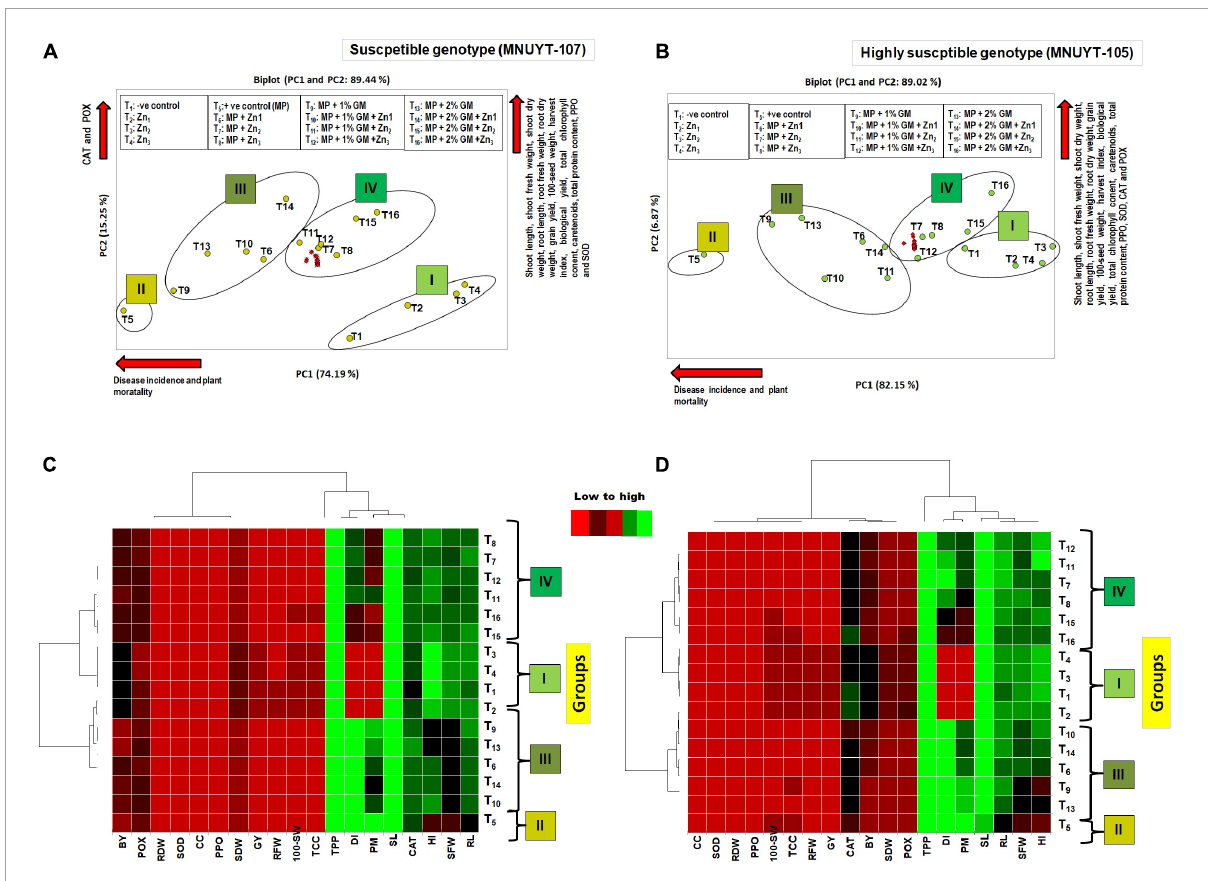
FIGURE4 (A–D) Principal component analysis and heatmap of disease pressure, biophysical, biochemical traits of mungbean genotypes due to the effect of Macrophomina phaseolina (MP), zinc (Zn), and green manure (GM) in pots bioassays. DI, disease incidence; PM, plant mortality; SL, shoot length; SFW, shoot fresh weight; SDW, shoot dry weight; RL, root length; RFW, root fresh weight; RDW, root dry weight; SW, 100 seed-weight; GY, grain yield; BY, biological yield; HI, harvest index; TCC, total chlorophyll content; CC, carotenoids; TPC, total protein content; SOD, superoxide dismutase; CAT, catalase; POX, peroxidase; PPO, polyphenol oxidase. In PCA diagram, the green circle represents treatments, and the red circle represents attributes. T 1 , –ve control; T 2 , Zn 1 (1.25 mg/kg); T 3 , Zn 2 (2.44 mg/kg); T 4 , Zn 3 (5 mg/kg); T 5 , +ve control [ M. phaseolina (MP)]; T 6 , Zn 1 (1.25 mg/kg) + MP; T 7 , Zn 2 (2.44 mg/kg) + MP; T 8 , Zn 3 (5 mg/kg) + MP; T 9 , 1% GM + MP; T 10 , 1% GM + MP + Zn 1 (1.25 mg/kg); T 11 , 1% GM + MP + Zn 2 (2.44 mg/kg); T 12 , 1% GM + MP + Zn 3 (5 mg/kg); T 13 , 2% GM + MP; T 14 , 2% GM + MP + Zn 1 (1.25 mg/kg); T 15 ,